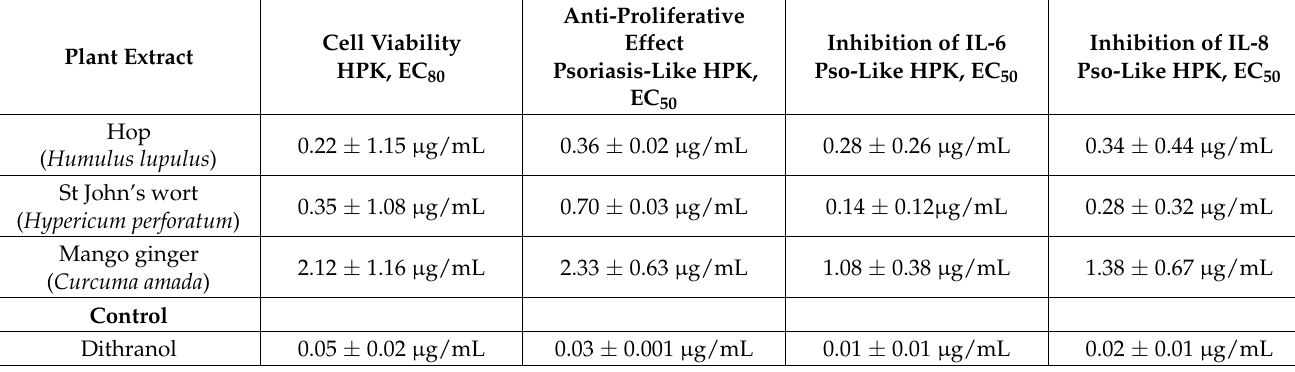
Table 2. Anti-proliferative and anti-inflammatory potential of Humulus lupulus , Hypericum perforatum and Curcuma amada . Anti-Proliferative Cell Viability Effect Plant Extract HPK, EC 80 Psoriasis-Like